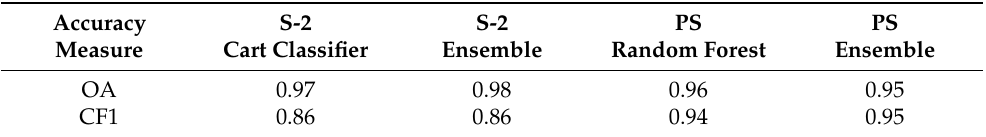
Table 3. Comparison of the best classification results for each sensor/classifier combination. OA = overall accuracy, CF1 = combined F1 score of drifting vegetation and beach